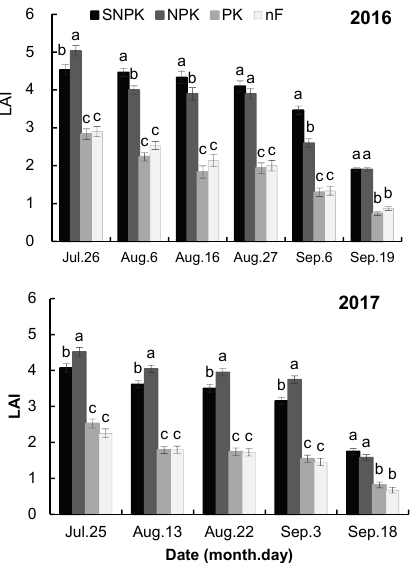
Figure 3. Leaf area index (LAI) post-flowering as effect of long-term fertilizer treatment SNPK, NPK, PK, and nF. SNPK represents combination of maize straw, chemical nitrogen, phosphorus, and potassium, NPK represents treatment of chemical nitrogen, phosphorus, and potassium, PK represents chemical phosphorus and potassium, and nF represents no fertilizer. Values with the same letter are not significantly different at p < 0.05, comparison within the same sampling date. Bars: Standard error of mean. Agronomy 2018 , 8 , x FOR PEER REVIEW